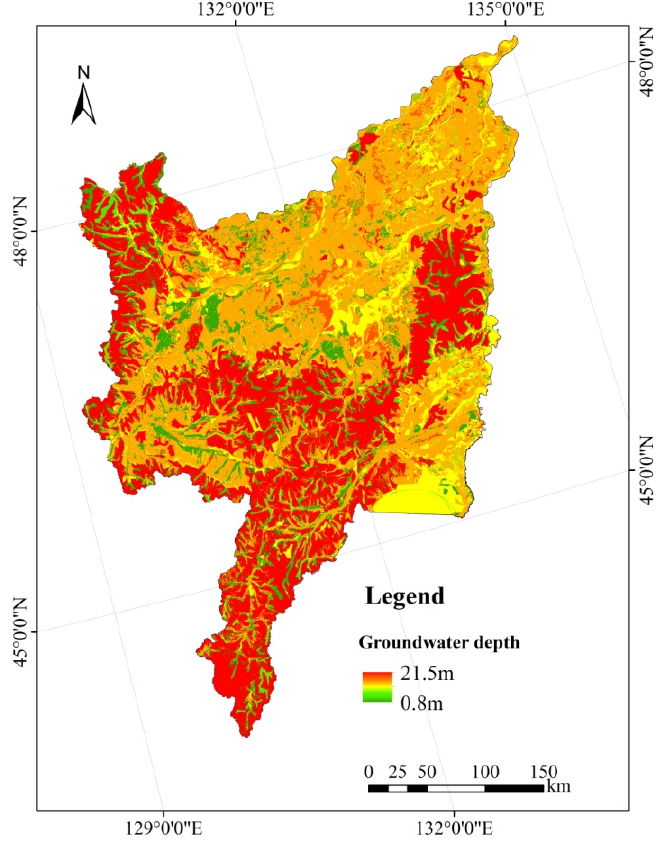
Figure 10. Groundwater depth for 2013 in the Sanjiang Plain, Northeast